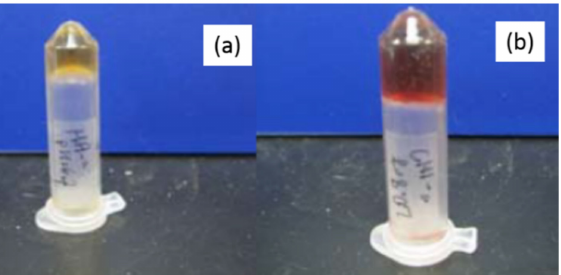
Figure 6. Pictures of polymers gelled by periodate. ( a ) Catechol-modified HA, ( b ) Catechol-modified CHI. The diameter of the tube was approximately 1